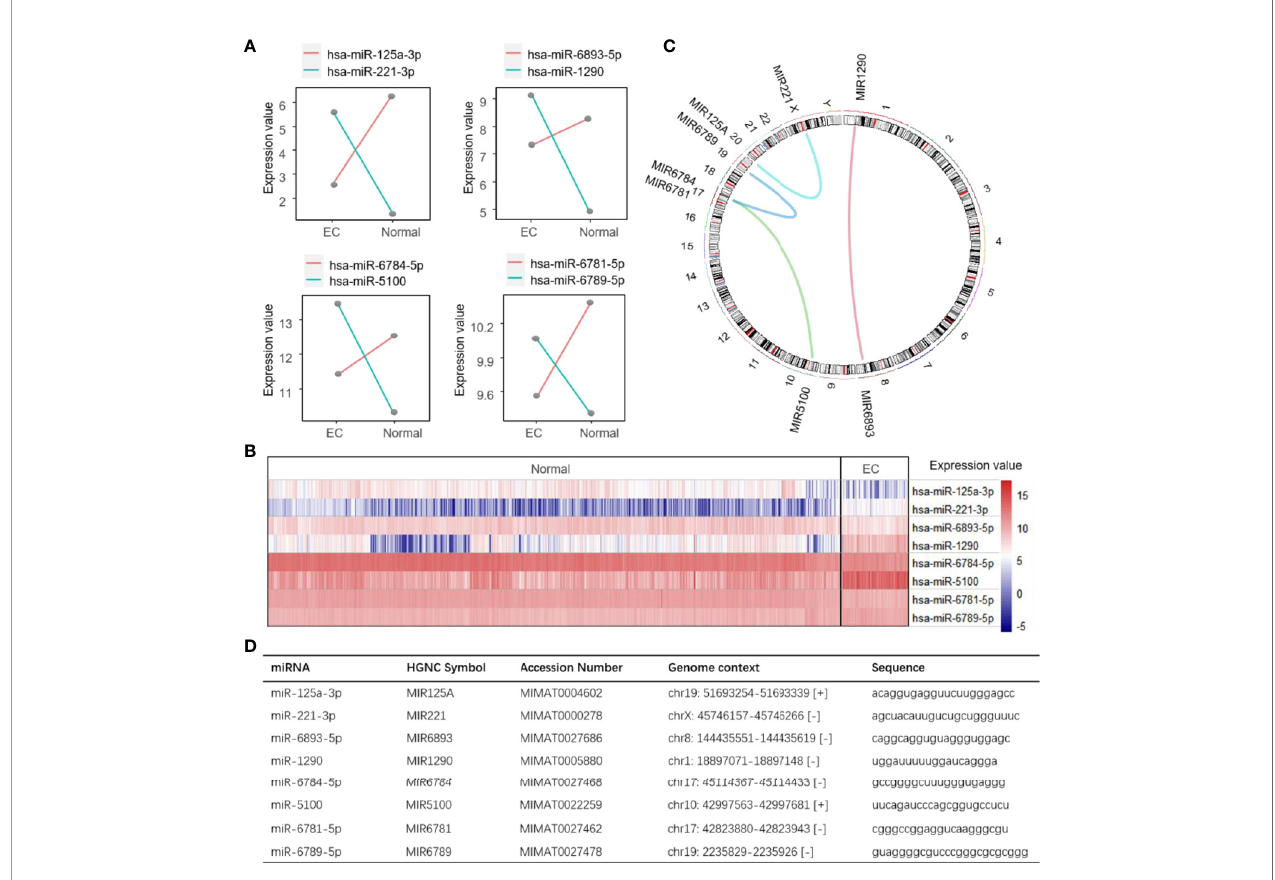
FIGURE 2 | Summarization of the four miRNA pairs. (A) Expression values of the four identi fi ed miRNA pairs. Line represents the average expression abundance in EC and normal states for a miRNA in the training set. Two lines are intersecting when a pair of miRNAs are reversed in expression between the EC and normal state. (B) Heatmap showing the expression value of the four miRNA pairs between EC and normal samples in the training set. (C) A circos plot showing the location of the four miRNA pairs in chromosome. Curves in the circle represent the miRNA pairs. (D) The genetic information of the miRNA